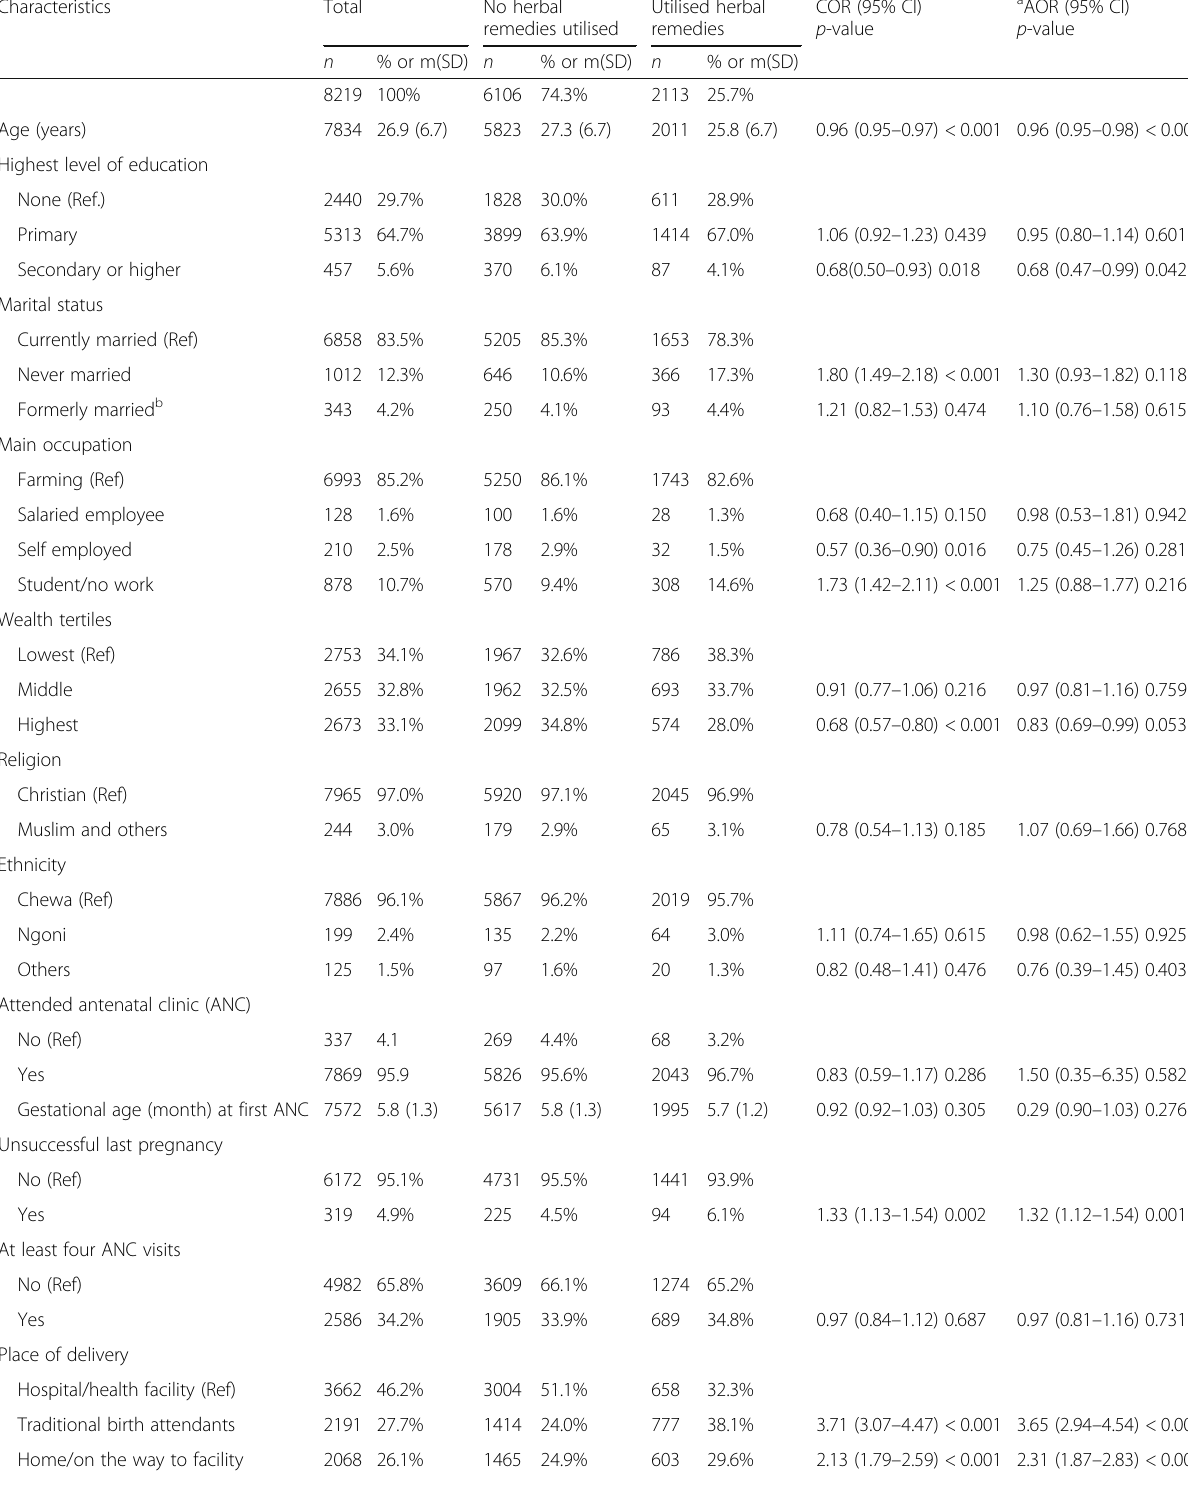
Table 1 Characteristics of participants and factors associated with utilisation of Mwanamphepo during pregnancy (Mixed-effects model, adjusted for